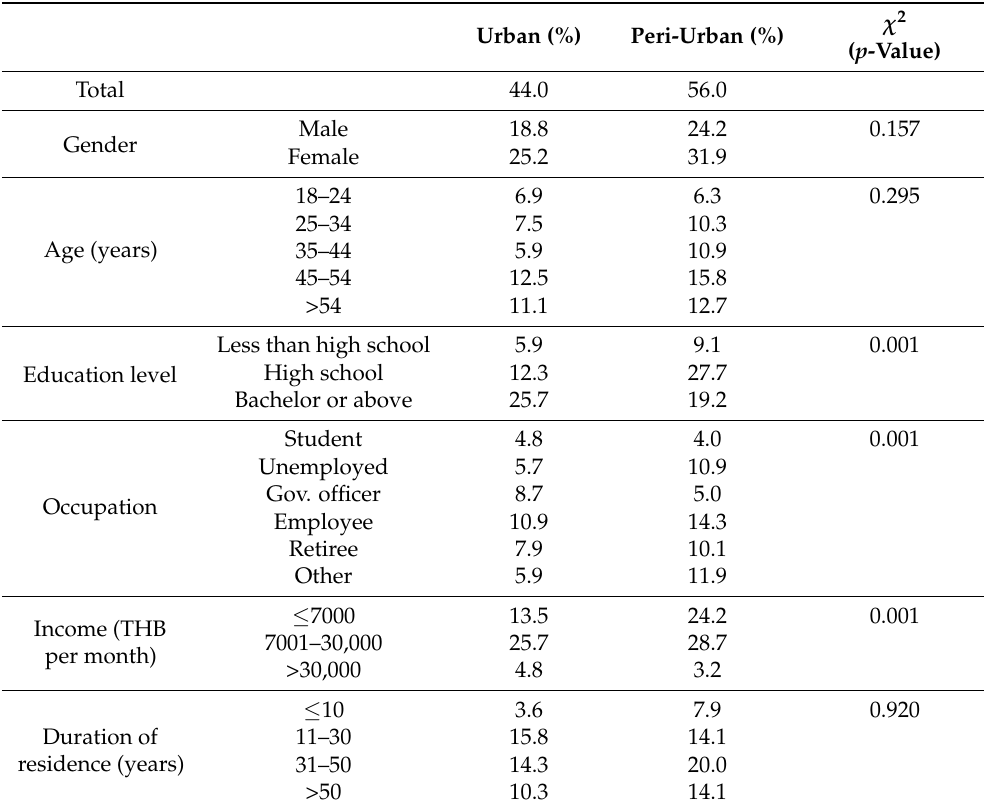
Table 1. The respondents’ characteristics in urban and peri-urban areas ( n =